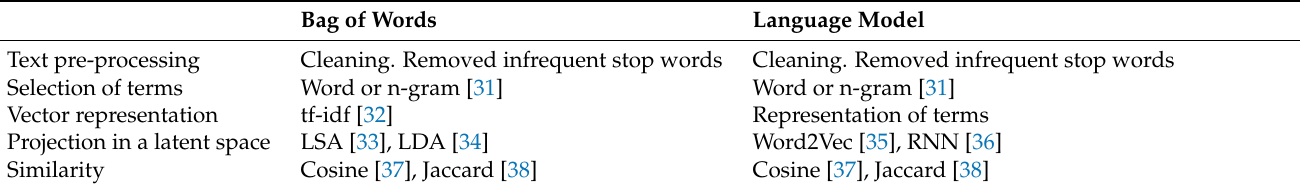
Table 1. NLP and